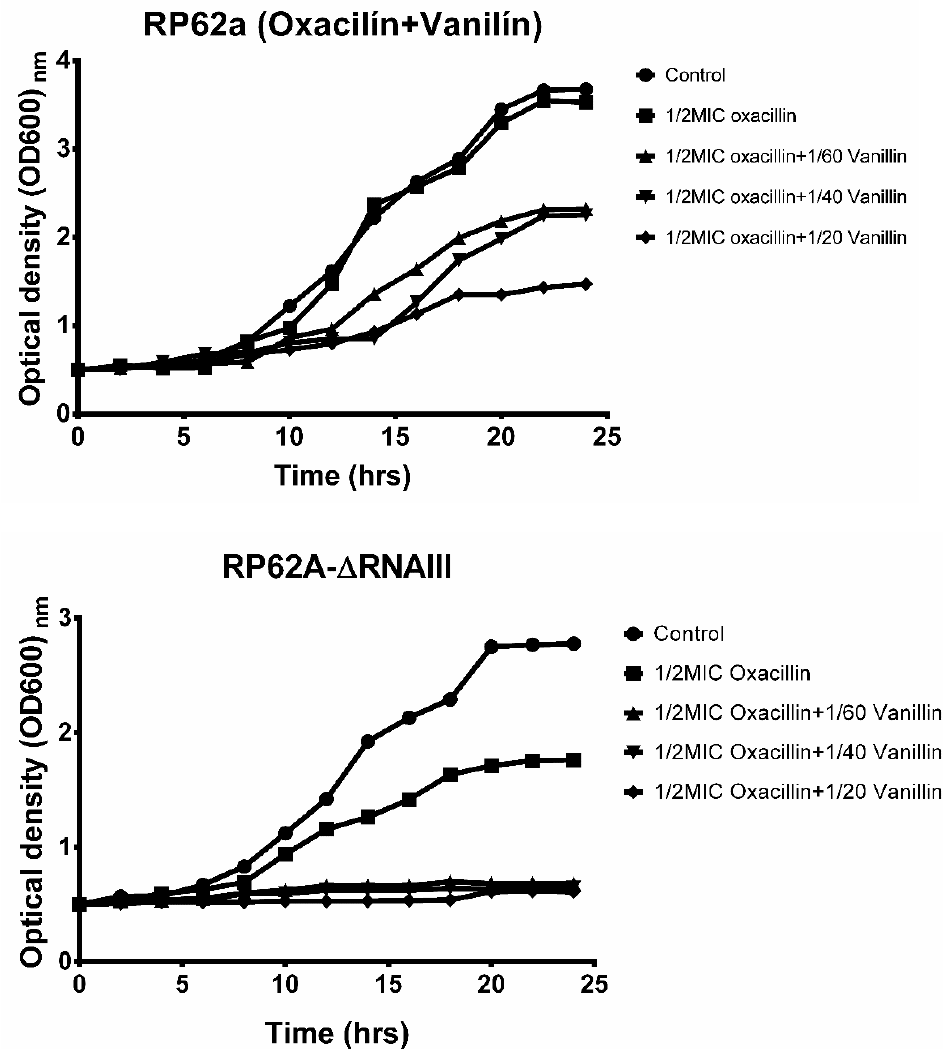
Figure 3. Effect of oxacillin in combination with vanillin on the growth of the methicillin-resistant strain S. epidermidis RP62a and the deletion mutant S. epidermidis RP62a- Δ RNAIII.